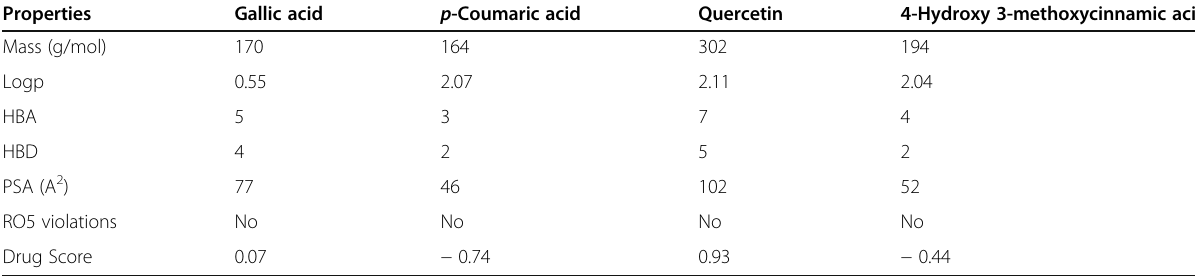
Table 3 Drug likeness analyses of phytocompounds